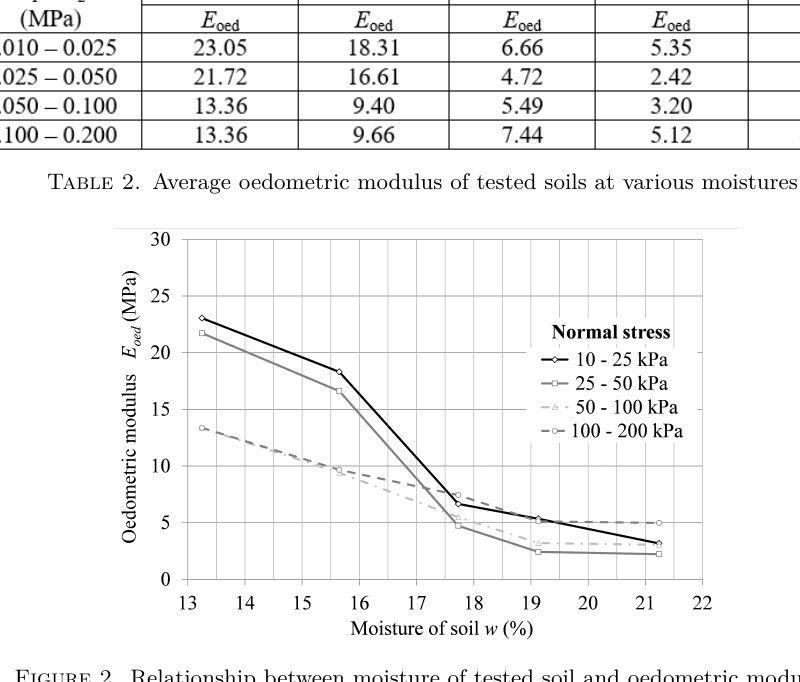
Figure 2. Relationship between moisture of tested soil and oedometric